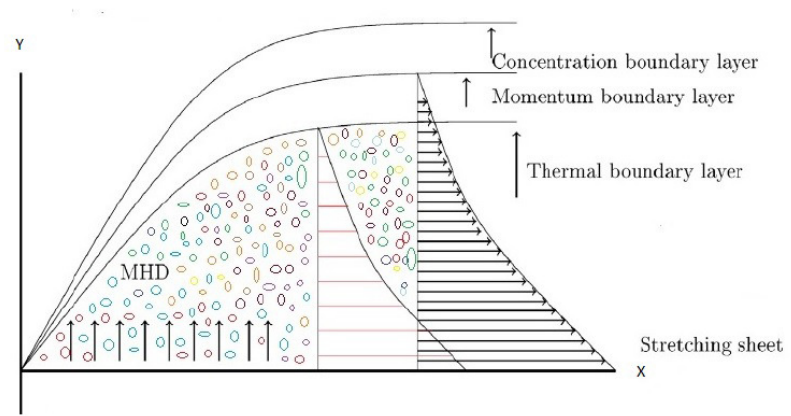
Figure 1. The flow schematic